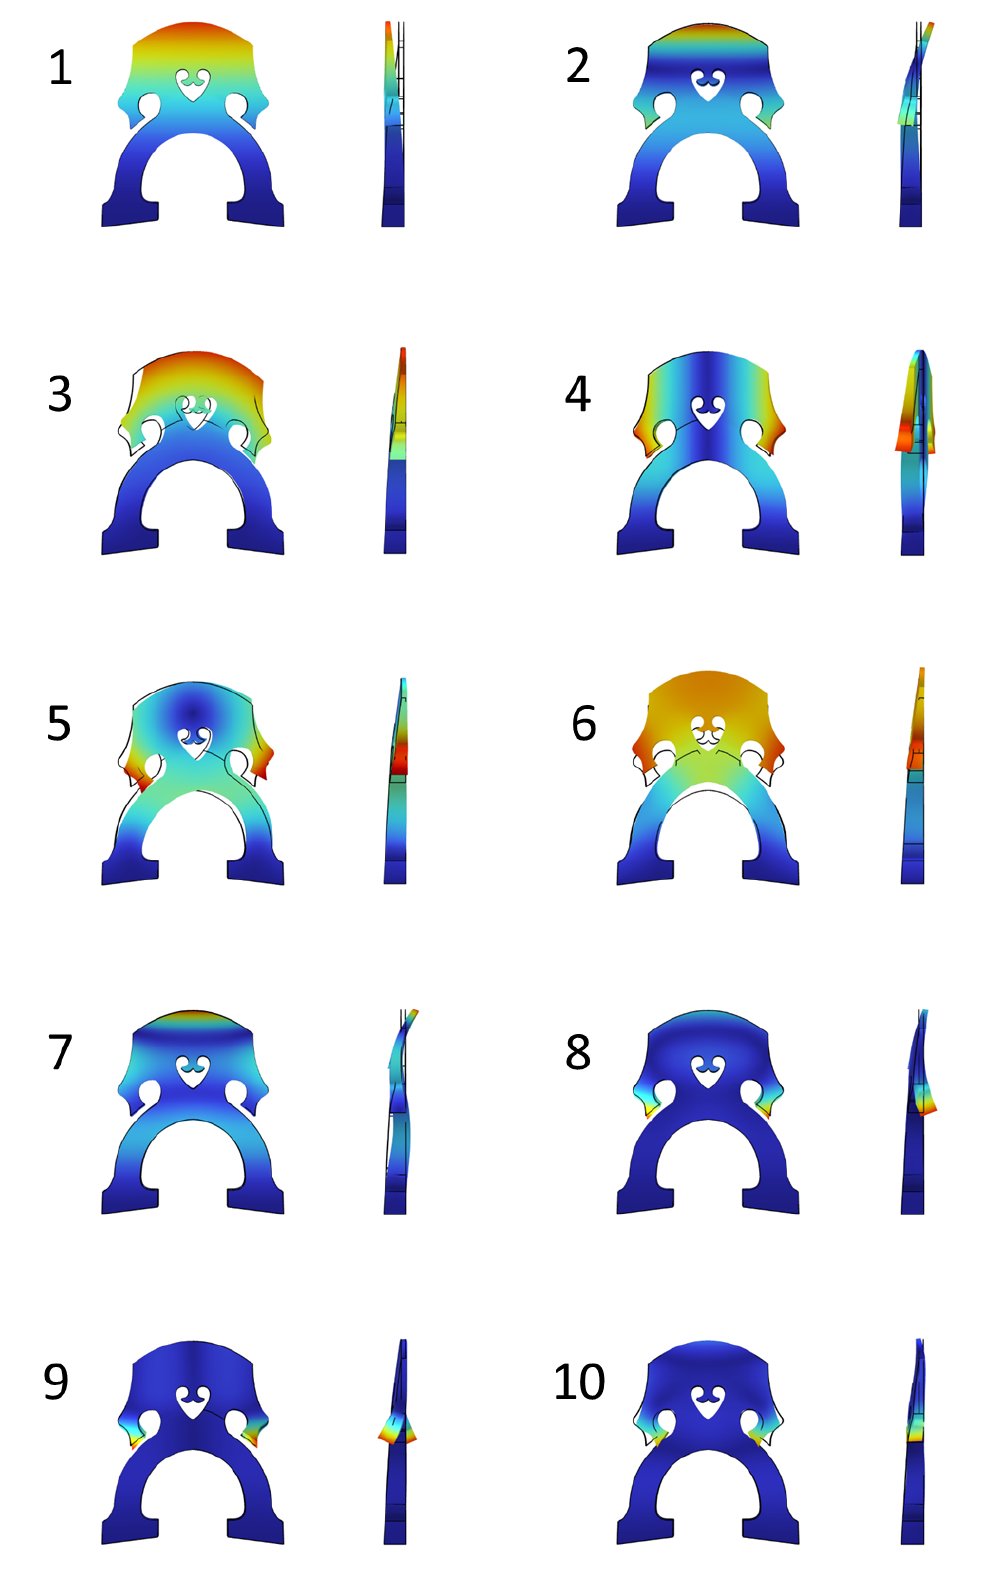
Figure A4. Mode shapes in fixed boundary conditions (case (b)) for the Normal